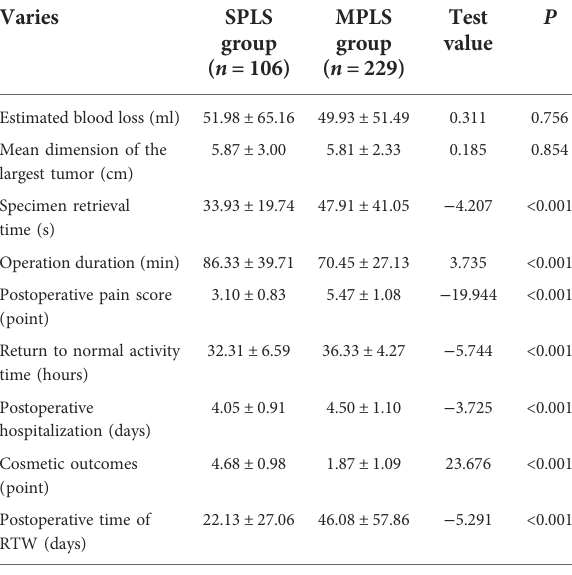
TABLE 2 Surgical outcomes of patients with benign ovarian tumor in the SPLS and MPLS